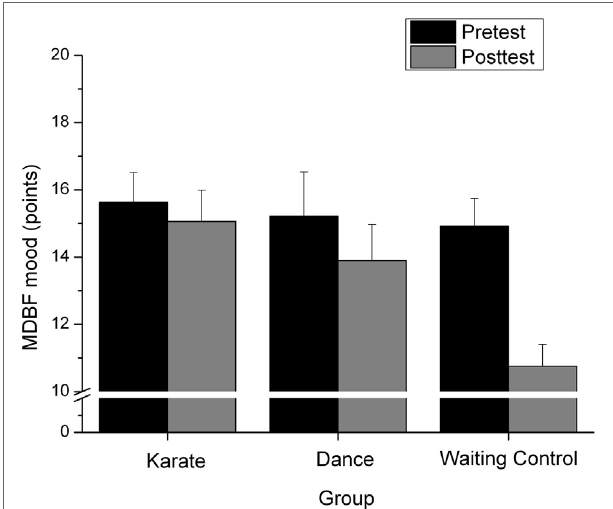
FigUre 1 | Points in the mood measurement in the MDBF (in the pretest and posttest) for the karate, dance and waiting control